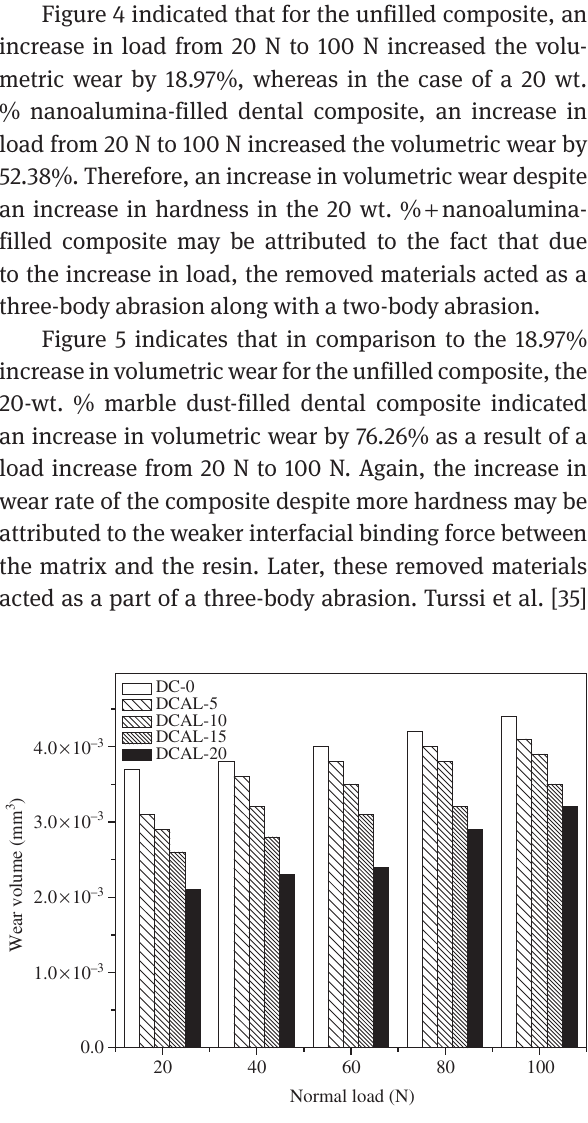
Figure 4: Effect of normal load on wear volume of the nanoalumina- filled dental